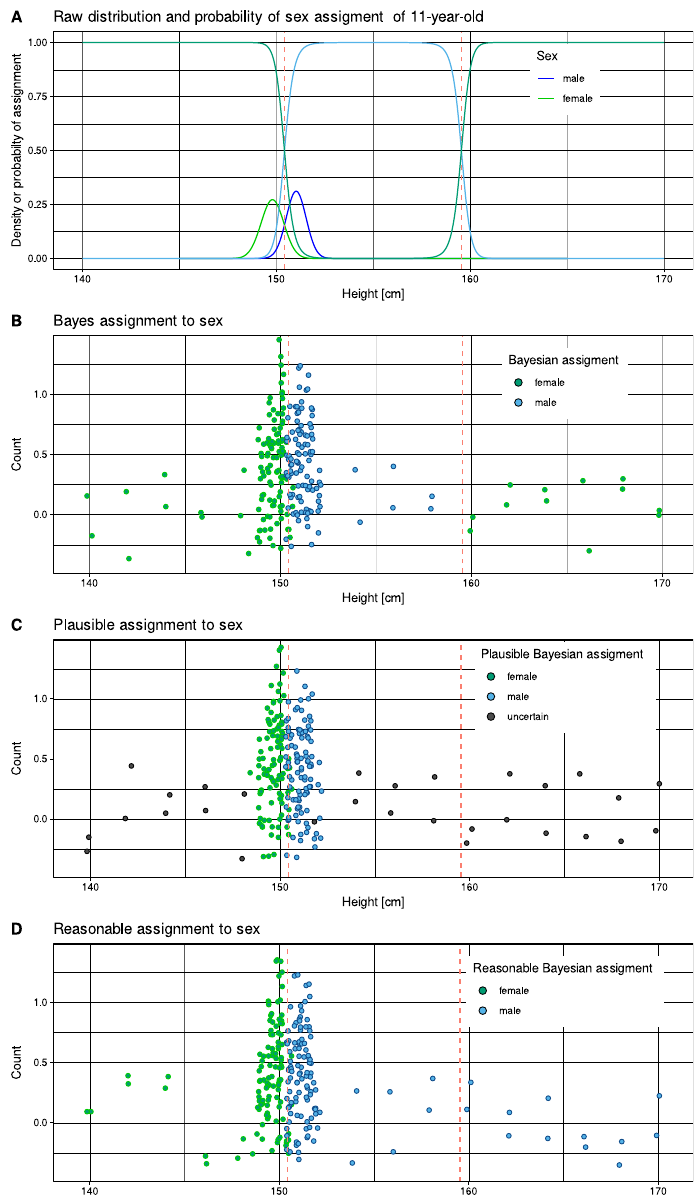
Figure 2. Distribution of body heights 11-year-old girls (red) and boys (blue) and assignment to sex based on Bayesian posteriors of observations of sex-specific body height [9]. ( A ) Probability density functions based on observed mean and standard deviation values of 149.8081 ± 0.5843 cm for girls and 151.0295 ± 0.5108 cm for boys. In addition, Bayesian posterior probabilities of sex assignment are shown in lighter blue and red lines. Bayesian decision boundaries are shown as vertical red dashed lines. ( B ) Simulation of 100 heights per sex randomly drawn from a normal distribution with above means and standard deviations, and addition of 16 arbitrary heights between 140 and 170 cm in increments of 2 cm. Points are colored for assigned sex based on Bayesian posteriors shown in panel A. The points are jittered for better distinguishability. ( C ) Following the method of reasonable Bayes proposed in this report, cases with certain versus uncertain class assignment were identified, which occurred in marginal regions where the probability density functions of the data classes were very low. ( D ) For cases unclassified by the above method, sex assignment was substituted based on the “plausible Bayes” method proposed in this report. The figure has been created using the R software package (version 4.1.3 for Linux; https://CRAN.R-project.org/ (accessed on 18 September 2022) [12] (accessed on 18 September 2022) and the R library